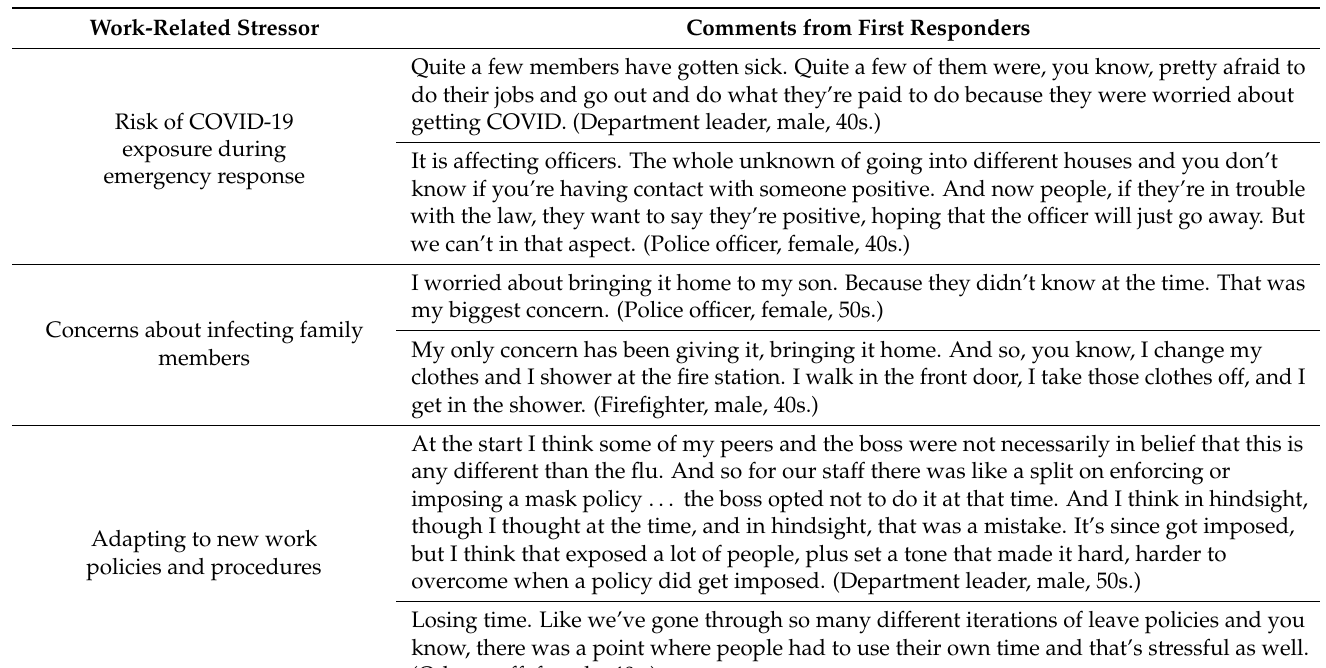
Table 5. Stress induced by